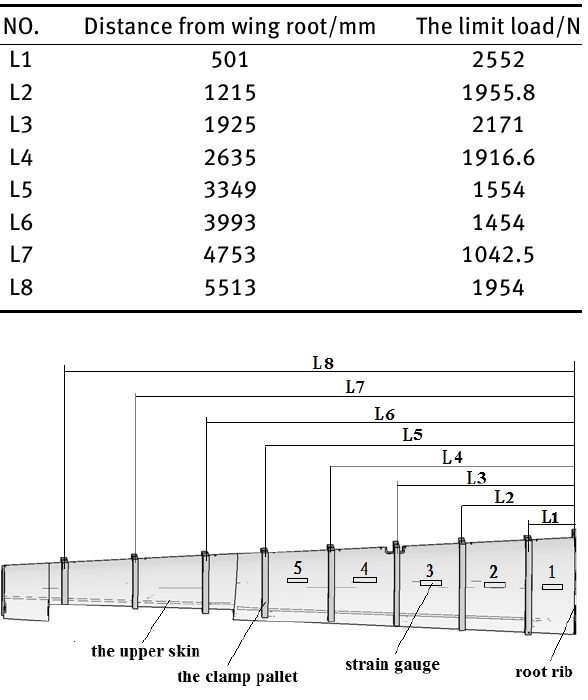
Figure 5: Position of strain gauge